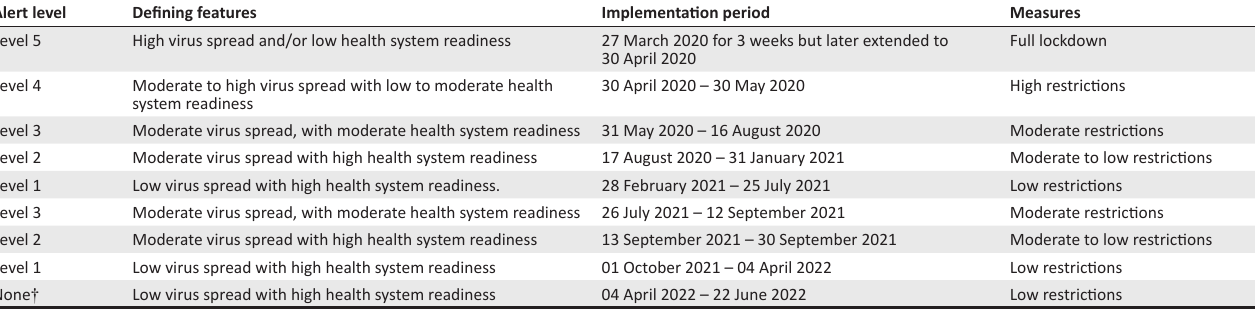
TABLE 1: South Africa’s risk-adjusted strategy or framework for phasing out coronavirus disease 2019 (COVID-19) lockdowns. Alert